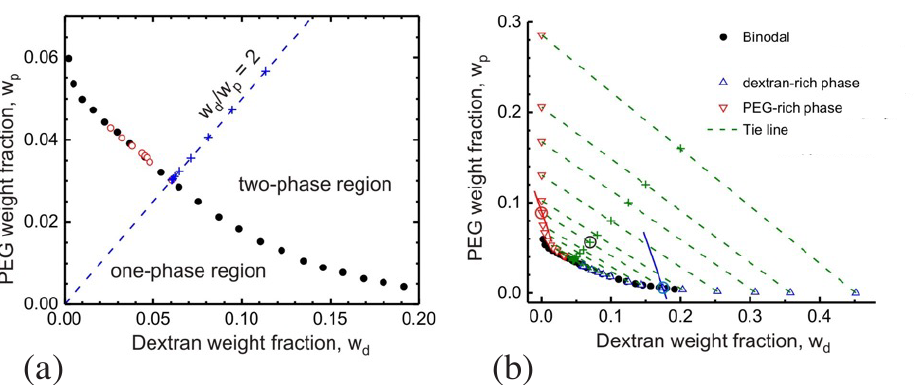
Figure 4. Phase diagram for aqueous PEG-dextran solutions at room temperature in terms of the weight fractions w d and w p of dextran and PEG. The binodal line (black and red data points) separates the one-phase region at low weight fractions from the two-phase region at higher weight fractions. The dashed line in ( a ) corresponds to constant weight fraction ratio w d / w p = 2. The green dashed lines in ( b ) represent tie lines in the two-phase region. Each tie line has two end points which lie on the binodal. When the weight fractions are located on a certain tie line, the solution phase separates into a PEG-rich and a dextran-rich phase. The compositions of these two coexisting phases are given by the end points of the tie line as indicated by upward-pointing triangles for the dextran-rich phase and by downward-pointing triangles for the PEG-rich phase. These compositions can be determined from the measured mass densities of the two coexisting phases by constructing isopycnic lines of constant